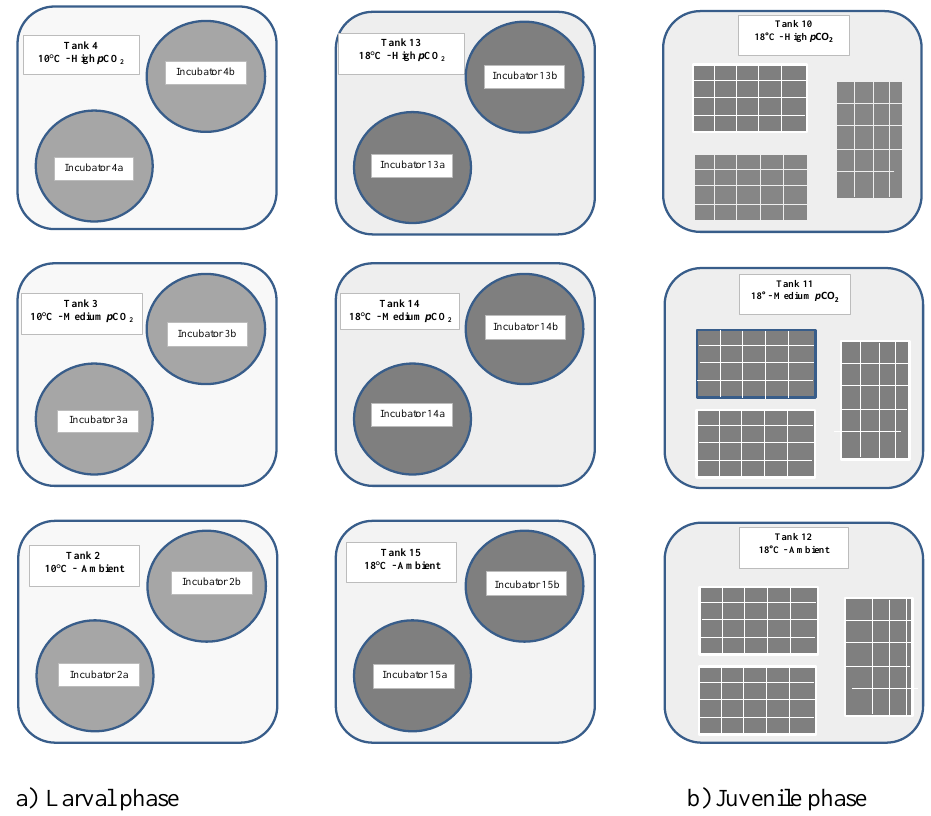
Fig. 1. Overview of the experimental setup during the (a) larval (two incubators as parallels in each tank unit) and in the (b) juvenile phase Figure 1. with trays with individual compartments (several trays in each tank